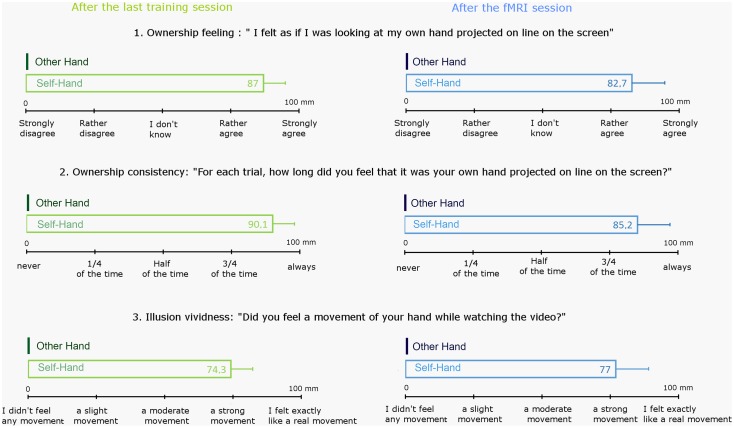
Responses to the questionnaire that participants filled after the last training session (green) and after the fMRI session (blue) to assess ownership feeling over the video projected hand (question 1), the consistency of ownership feeling (question 2), and the vividness of the kinesthetic sensation (question 3).Histograms are mean responses (+ standard deviation) reported by all participants on 100 mm analogue scales. It is important to note that the Other Hand video was specifically selected so it did not induce any feeling of ownership nor any sensation of movement (cf methods section).